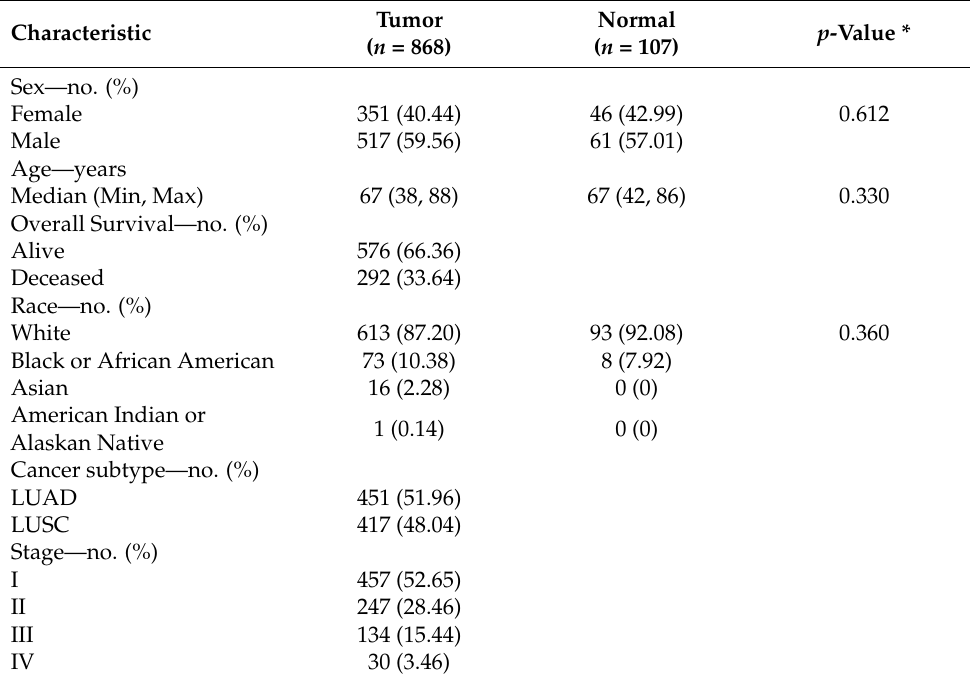
Table 1. Clinical characteristics of the Cancer Genome Atlas